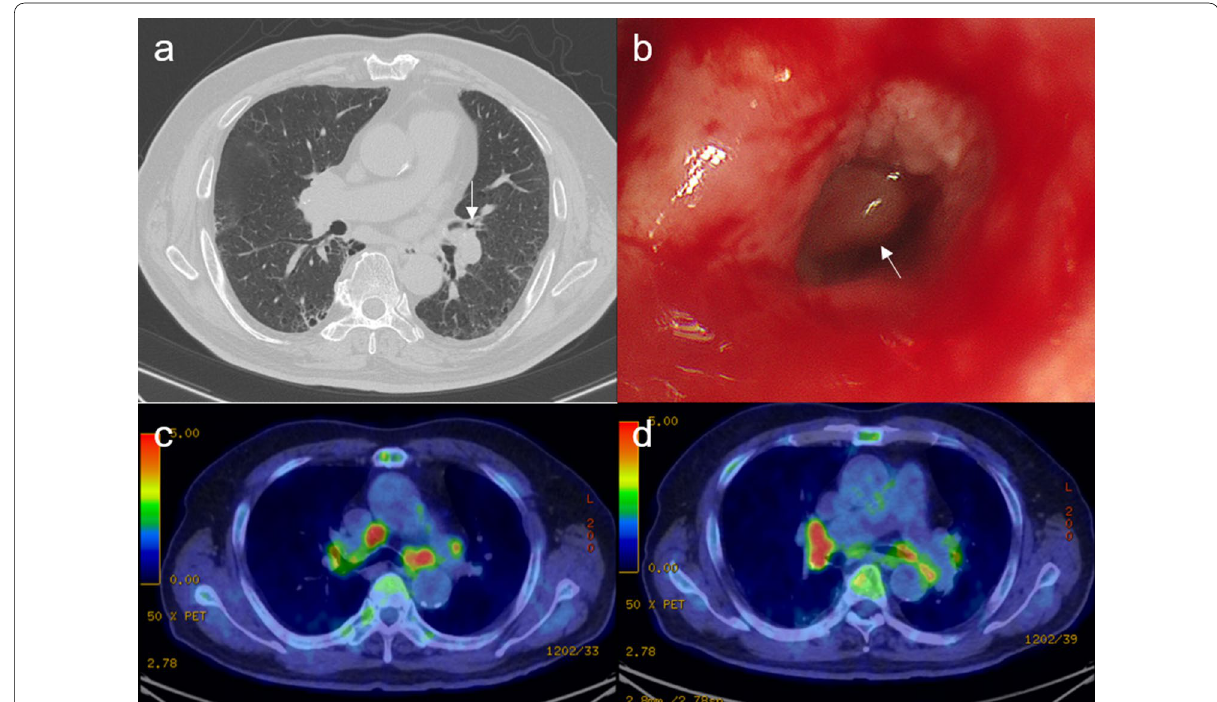
Fig. 1 Preoperative findings. a Computed tomography shows a polypoid nodular shadow in the left superior lingual bronchus (white arrow) without lymphadenopathy. b Bronchoscopy shows a polypoid nodule in the left superior lingual bronchus (white arrow). c , d Accumulation of 2-deoxy-2-(18F)-fluorodeoxyglucose up to the maximal standardized uptake value of 6.0 is observed in the bilateral hilar and mediastinal lymph